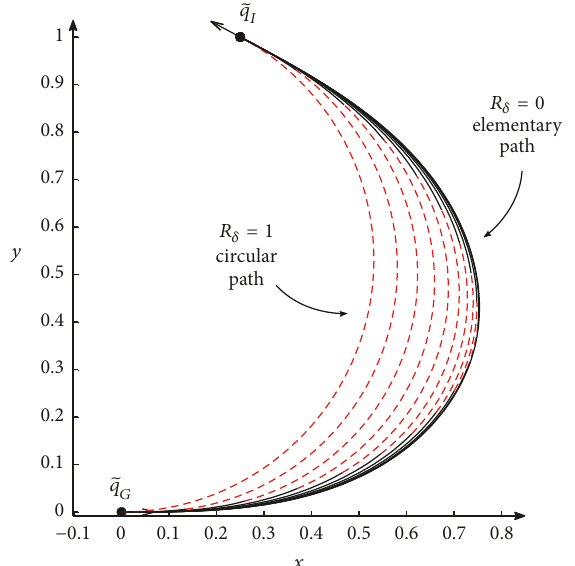
Figure 7: Effect of 𝑅 𝛿 on the shape of a CC-turn ( 𝑅 𝛿 is modified in steps of